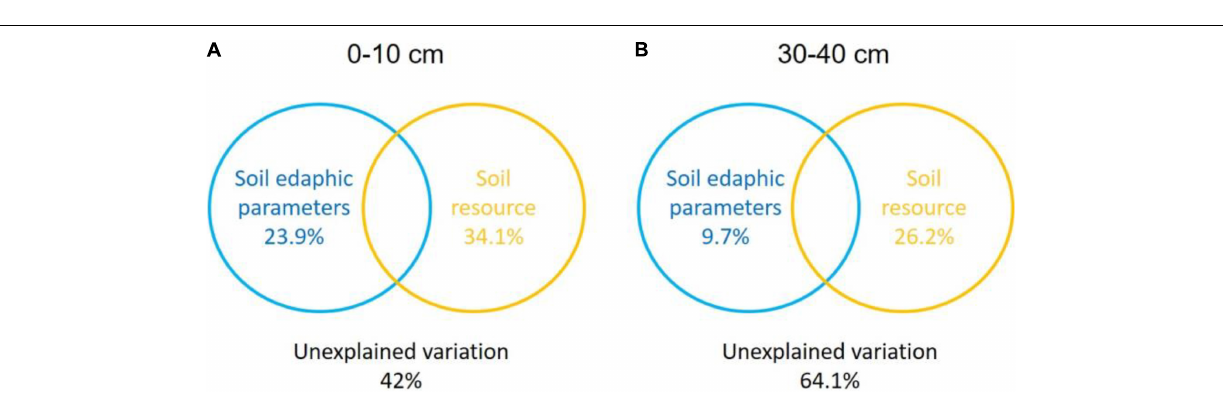
FIGURE 5 | Variance partitioning analysis (VPA) of the effects of soil physical parameter and soil resource supply on the variation in the NFGs distribution at a soil depth of 0–10 cm (A) and 30–40 cm (B) . Circles on the edges of the triangle show the percentage of variation explained by each variable.